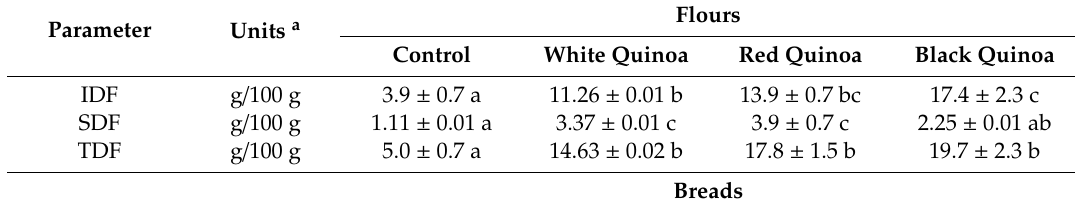
Table 4. Dietary fibre content in raw materials and breads and contribution to adequate intake. Parameter